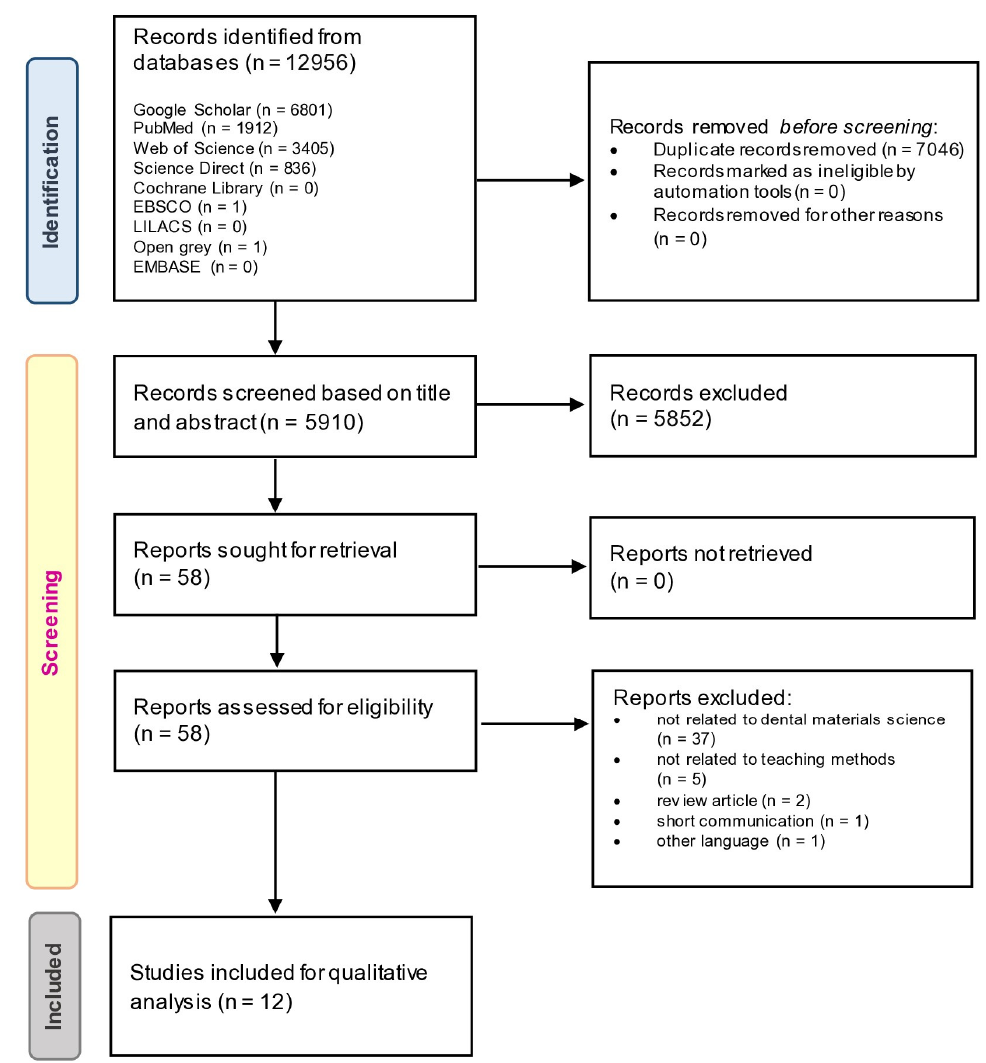
Figure 1. PRISMA flow diagram: number of records identified, included, and excluded, and the reasons for exclusions mapped out through the different phases of the current systematic review. Table 2. Characteristics of the selected primary studies.